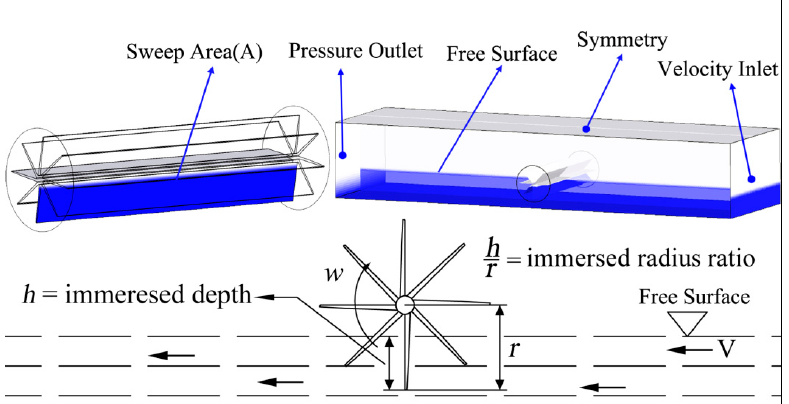
Figure 3. Boundary condition and diagram of water wheel operation.